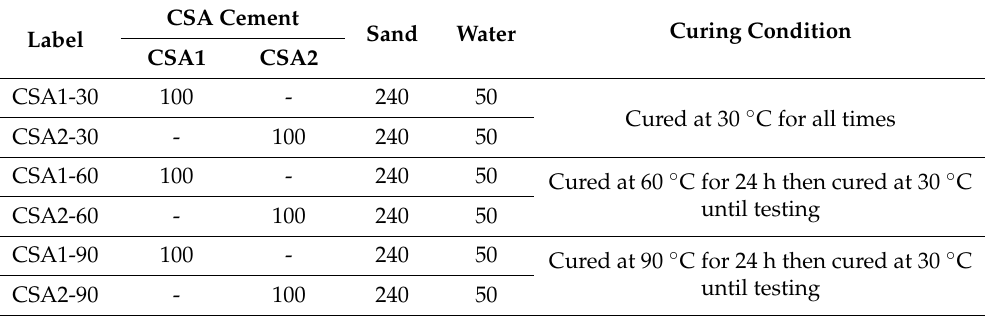
Table 2. Mixture proportions in weight ratios